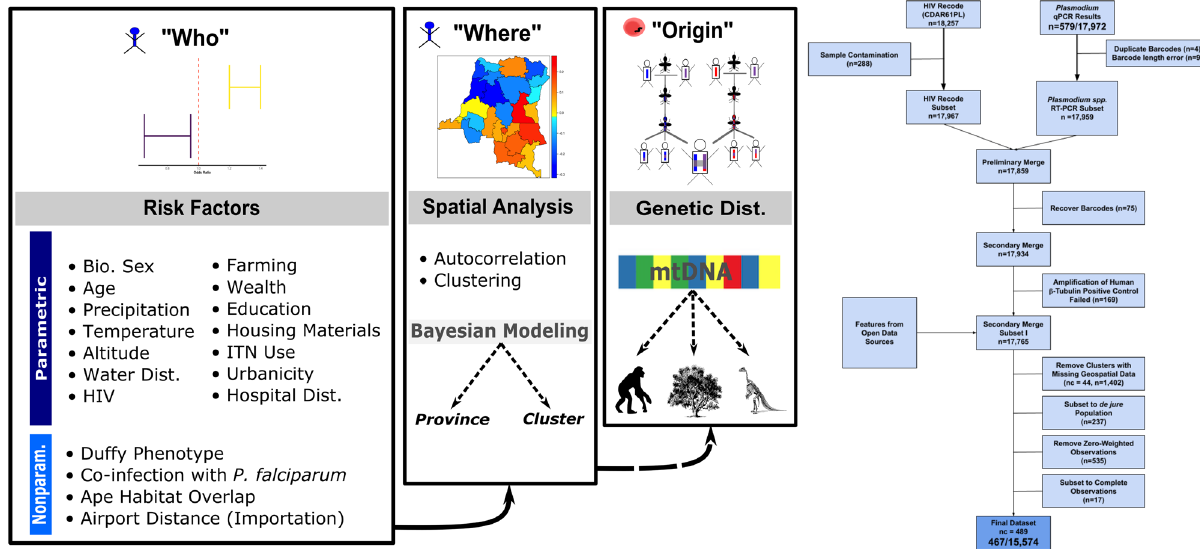
Fig. 1 Overview of study approach and inclusion. The conceptual diagram ( left ) describes the study approach to identify “ who ” was being infected by P. vivax , “ where ” P. vivax infections were occurring, and the potential source, or “ origin ” , of these infections. Risk factors identi fi ed in the “ who ” analysis, were considered in the spatial models. Genetic distance analyses were restricted to the mitochondrial genome (mtDNA) and few DRC samples ( n = 3). As a result, we limited this analysis to three broad questions: are the DRC samples most similar to (1) non-human apes mitochondrial strains; (2) contemporary P. vivax mitochondrial strains; or (3) an ancestral P. vivax mitochondrial strain. The fi nal data set ( right ) consisted of 467 P. vivax infections among 15,574 individuals across 489 clusters, prior to the application of the Demographic Health Survey (DHS) sampling weights. Speci fi cally, of the 18,257 Demographic Health Survey (DHS) records that had a dried blood spot, 17,972 samples were successfully shipped to the University of North Carolina for processing. Of these 17,972 samples, a small portion were lost due to barcoding errors, while the remaining 17,934 (99.79%) were successfully linked to the 2013 – 2014 DRC DHS survey. Of these 17,934 samples, 169 samples failed to amplify human beta-tubulin (i.e. positive control), 1402 individuals had missing geospatial data, 484 individuals were